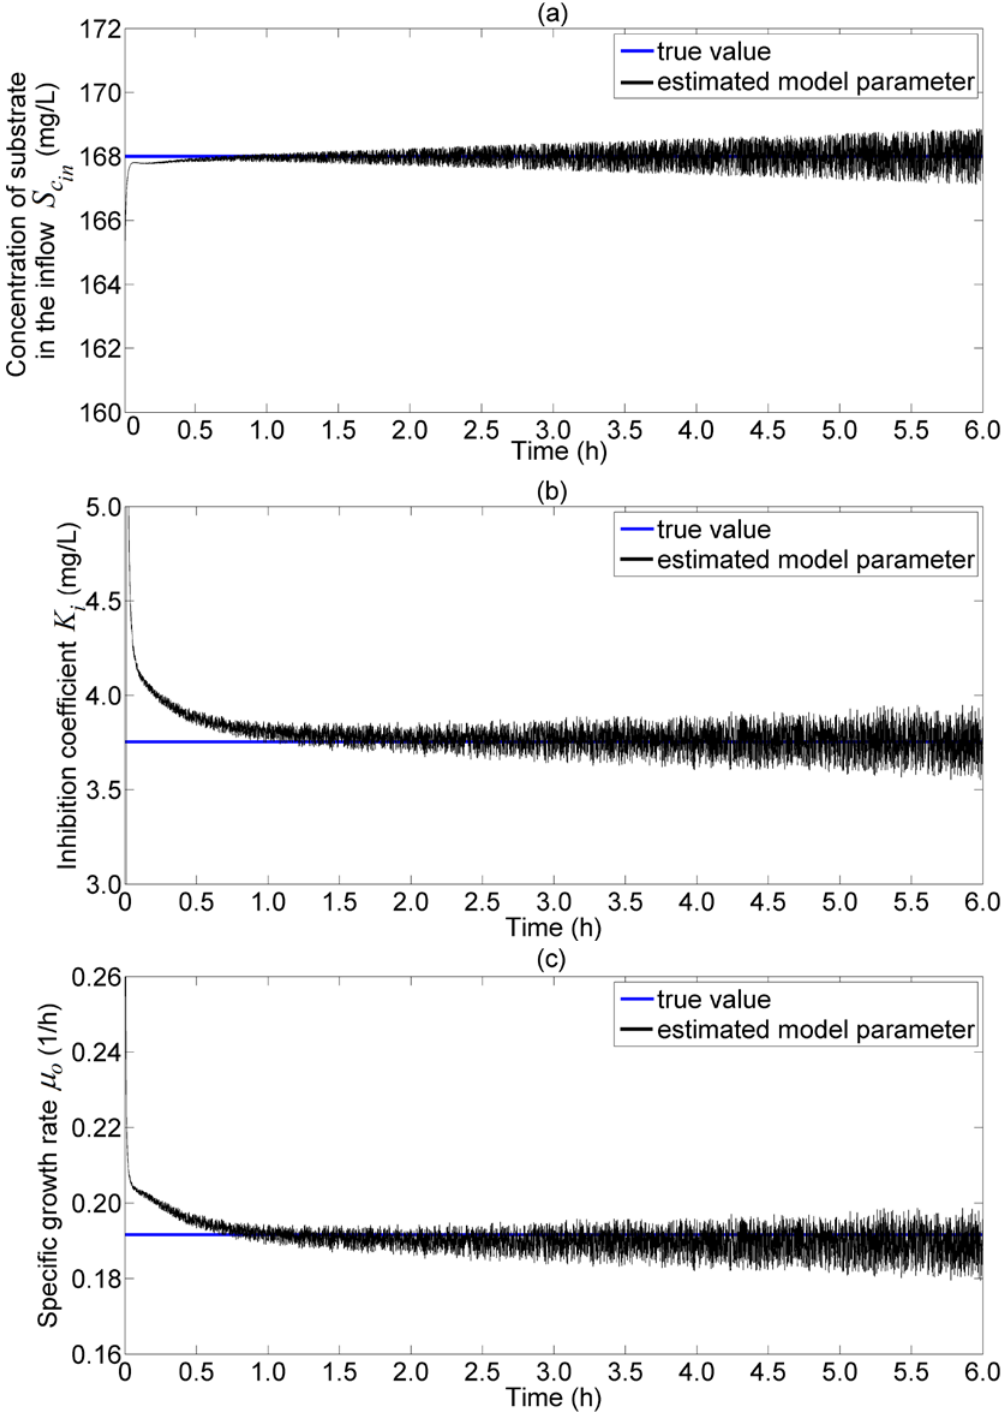
Figure 3. Estimated model parameters value for the fault-free scenario. ( a ) Concentration of substrate in the inflow, S c ; ( b ) inhibition coefficient, K i ; and ( c ) specific growth rate, µ o in